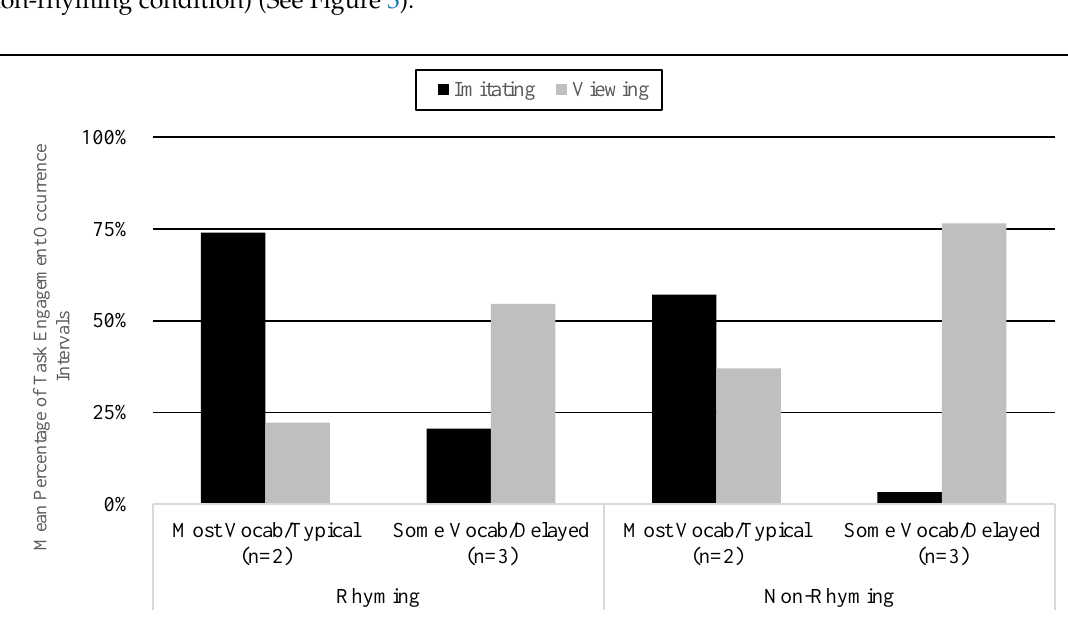
Figure 2. Engagement: Mean Percentage of Task Engagement Occurrence Intervals in Viewing and Imitating Behaviors.